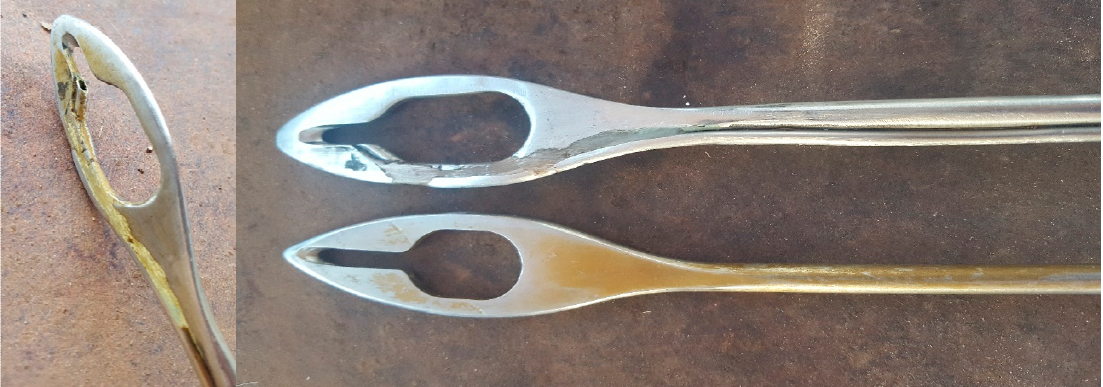
Figure 1. Modified Willis ovariotome (left and top right), with cylindrical metal tube attached parallel to the length of the tool, opening near the cutting slot. Willis ovariotome, unmodified (bottom right).